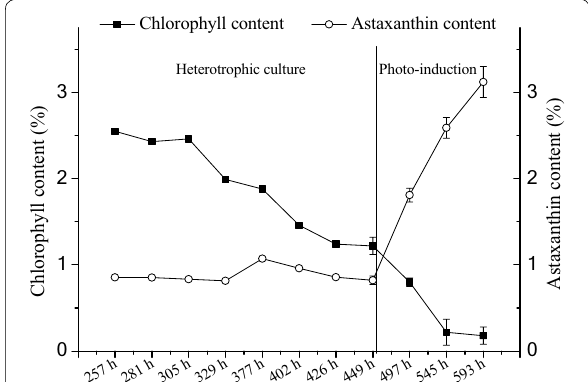
Fig. 5 Pigment changes during “sequential heterotrophy–dilution– photoinduction”